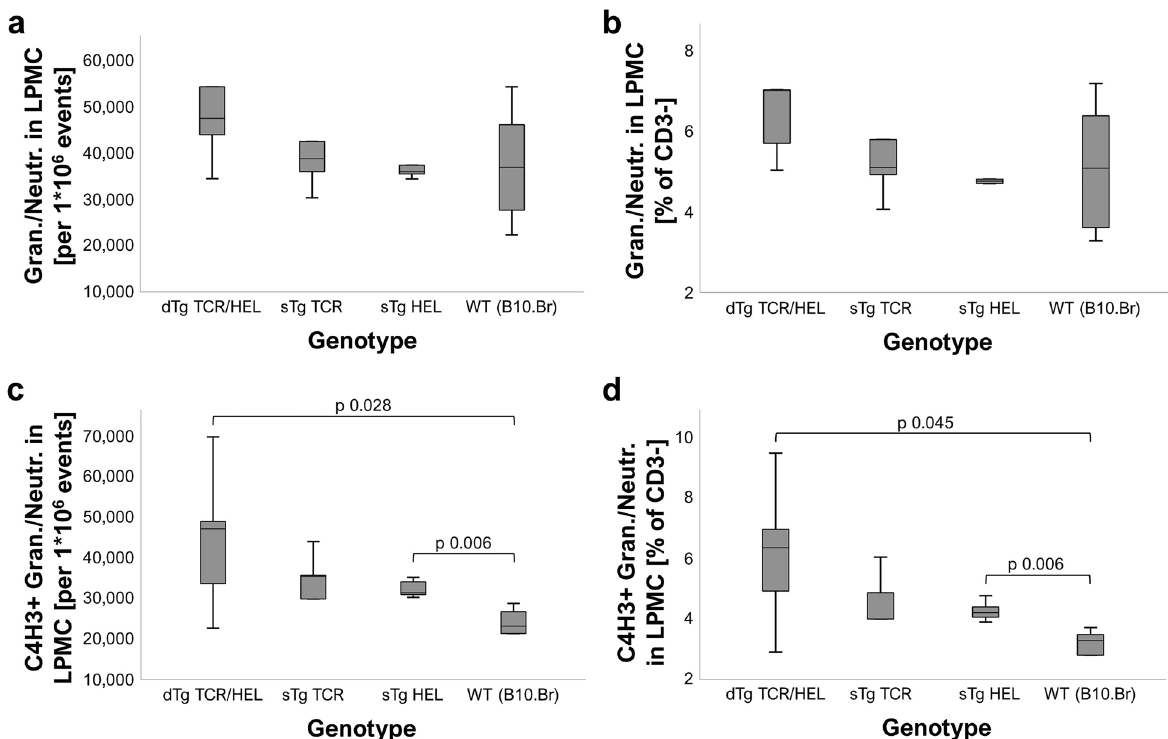
Figure 5. MHCII-HEL staining positivity is significantly stronger in lamina propria mononucleated cells isolated from dTg colon. MHCII-HEL complexes were detected using flow cytometry in granulocytes/ neutrophils in LPMC (lamina propria mononucleated cells) isolated from mouse colon (aged P30 ± 3). While no difference was found in either ( a ) total granulocyte/neutrophil numbers recorded, and ( b ) cell counts relative to all CD3- events, there were significantly more MHCII-HEL presenting cells [C4H3+; ( c ) and ( d )] found in LPMC isolated from dTg mice as compared to all other genotypes (= background level staining). This result is indicative of potential for HEL antigen presentation capacity in colons of dTg mice. Cells had been defined as CD3- CD11b+ Gr1/Ly6+. Non-parametric statistical procedures were used, significance taken as p ≤ 0.05. Per genotype group n = 5–7 mice were used across 2–3 independent